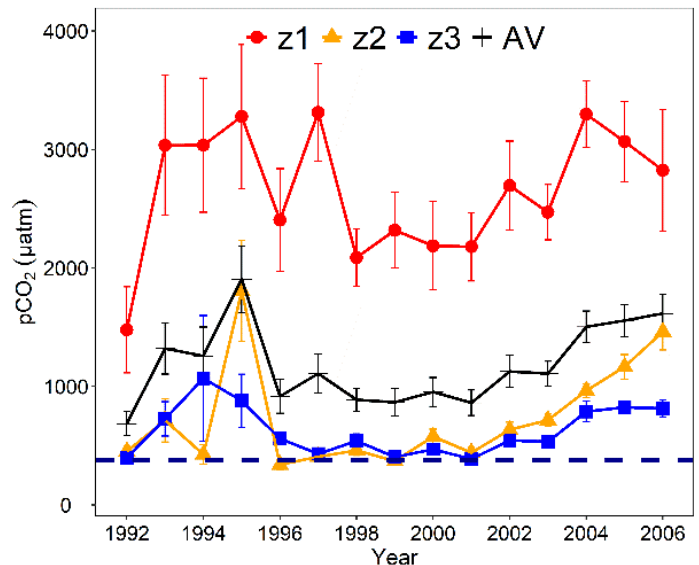
Figure 5. Dynamics of pCO 2 (mean ± SE) in Taihu Lake from 1992 to 2006 in three zones. AV represent the average values of three zones, the dashed blue line indicates the partial pressure of CO 2 in the atmosphere (380 μatm, see Figure S1).